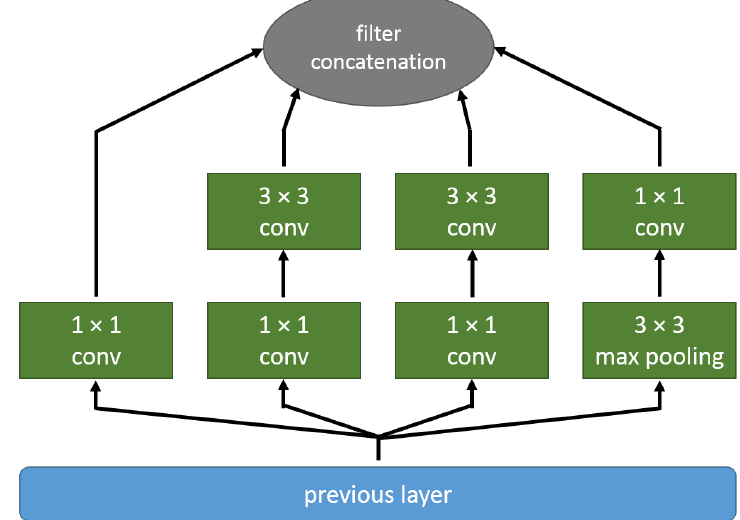
Figure 2. Example of the inception module: the output of the “previous layer” feeds four different feature extractors. The information provided from the different branches are merged by the layer “filter